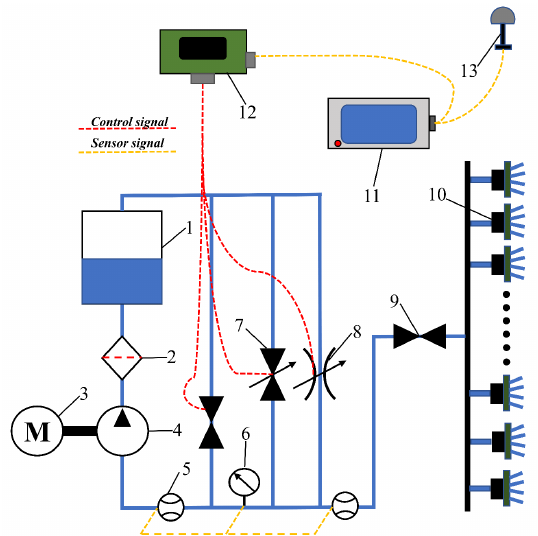
Figure 2. Structure of spraying system: 1, tank; 2, filter; 3, power source; 4, diaphragm pump; 5, flow sensor; 6, pressure sensor; 7, safety valve; 8, flow regulating valve; 9, divider valve; 10, nozzle; 11, onboard computer; 12, spray controller; 13, DGPS.